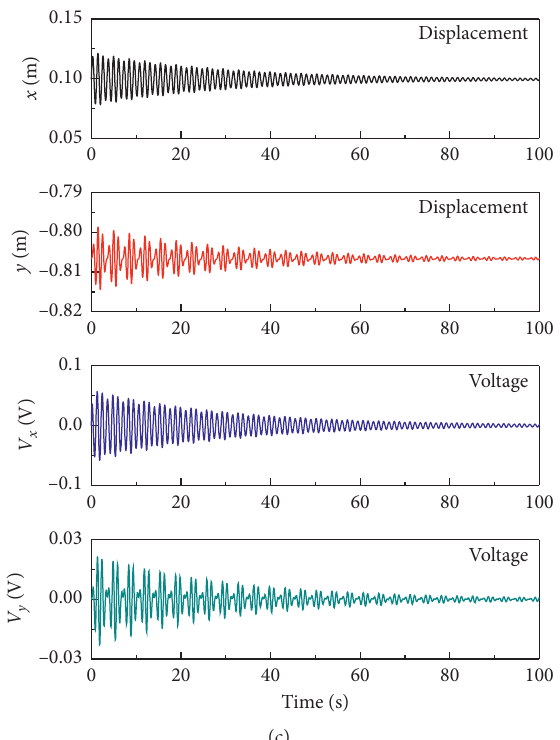
Figure 22: Considering separation, the displacement and output voltage of the friction system when the normal load is F � 20 N (a), F � 70N (b), and F � 120N